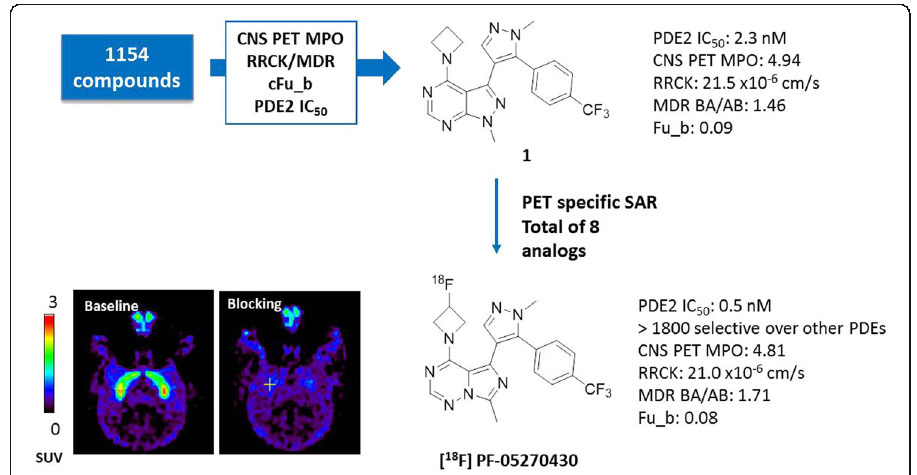
Fig. 4 Discovery of a PDF 2A -selective PET ligand [ 8 F]PF-05270430 guided by CNS PET ligand design